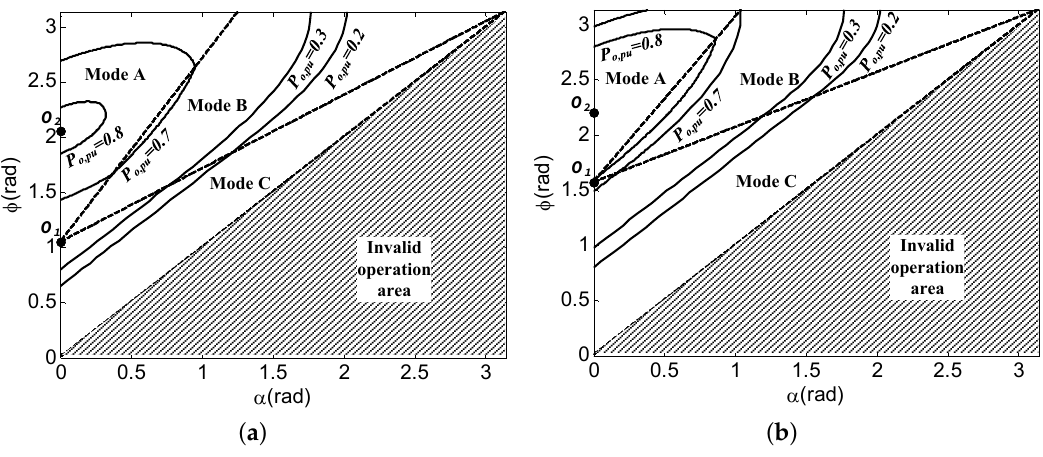
Figure 7. Operating range of each boost mode with suspended power contours for M = 1.5 and M = 2: ( a ) M = 1.5; ( b ) M =